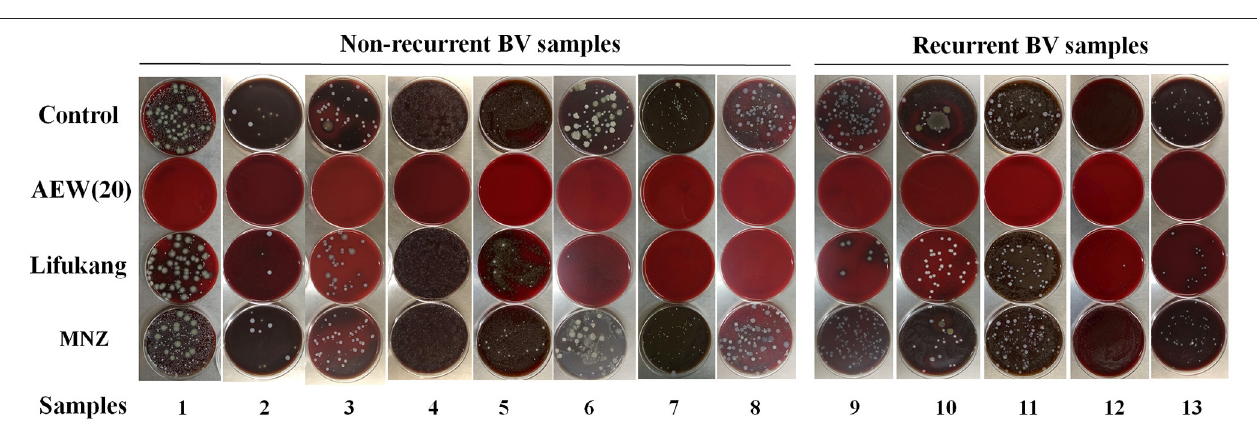
FIGURE 4 | Twenty ppm AEW induced ROS production in GS whereas it had less effect on LA. (A,C) Representative DCF fluorescence data were observed by flow cytometry. (B,D) Statistics of relative DCF fluorescence intensity of GS and LA were measured by flow cytometry ( n = 3, ** p < 0.01 to control).